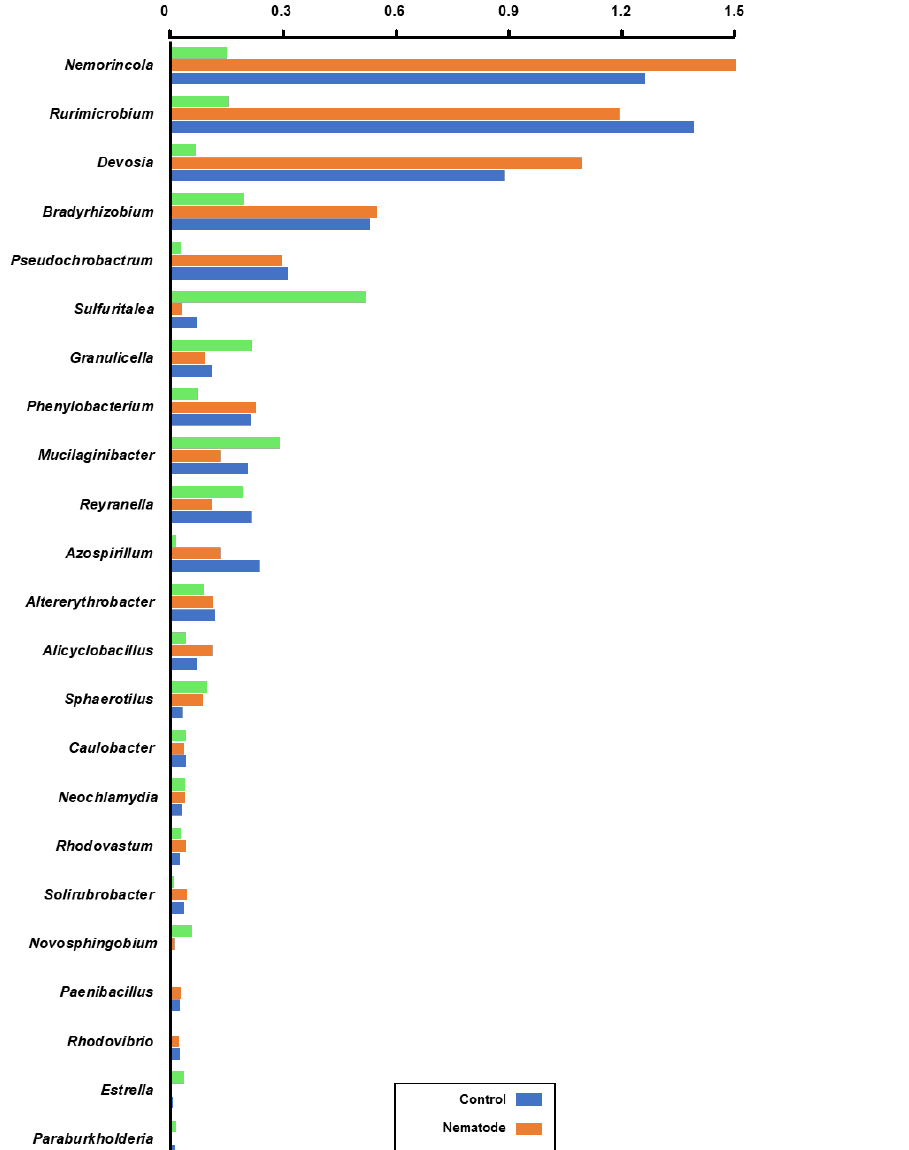
Figure 4. The relative abundance of bacterial genera in the rhizosphere of pine seedlings treated with methyl salicylic acid (MeSA) and followed by inoculation with the nematode, as compared to nematode-inoculated or control seedlings. Bacterial genera with significantly di ff erent ( p < 0.05) relative abundance after treatment with MeSA compared to controls are shown in the graph. The bars represent the mean values ( n =